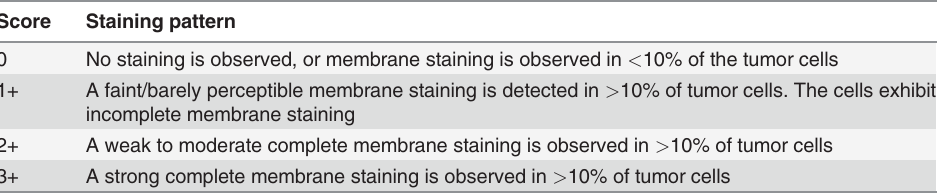
Table 1. Scoring of membranous IGF-1R